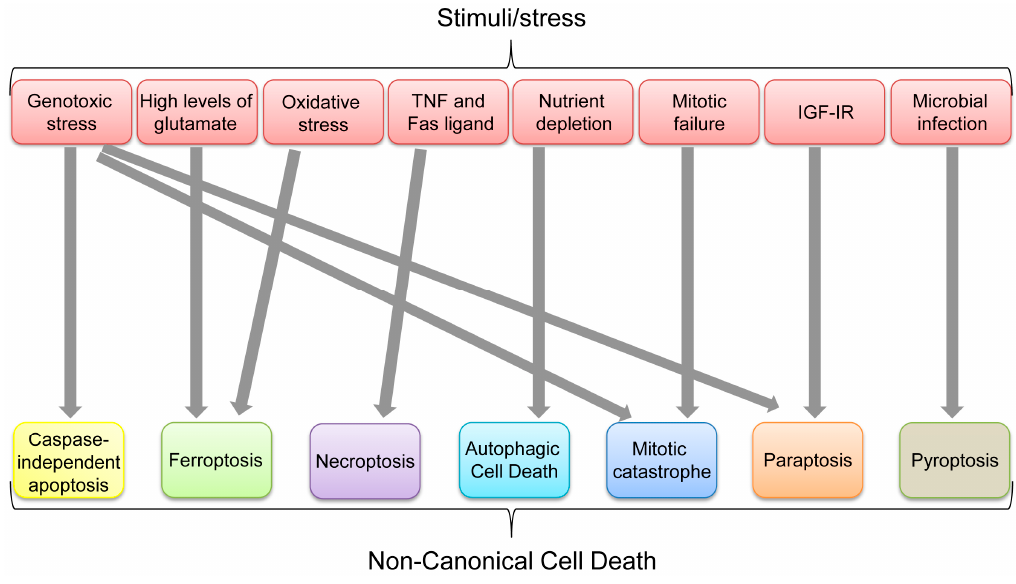
Figure 8. Non-canonical cell death induced by various stimuli/stress.